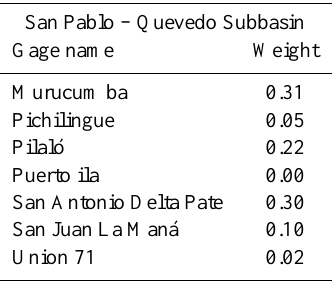
Table A3. Gage weights for San Pablo – Quevedo subbasin in the Vinces upper catchment